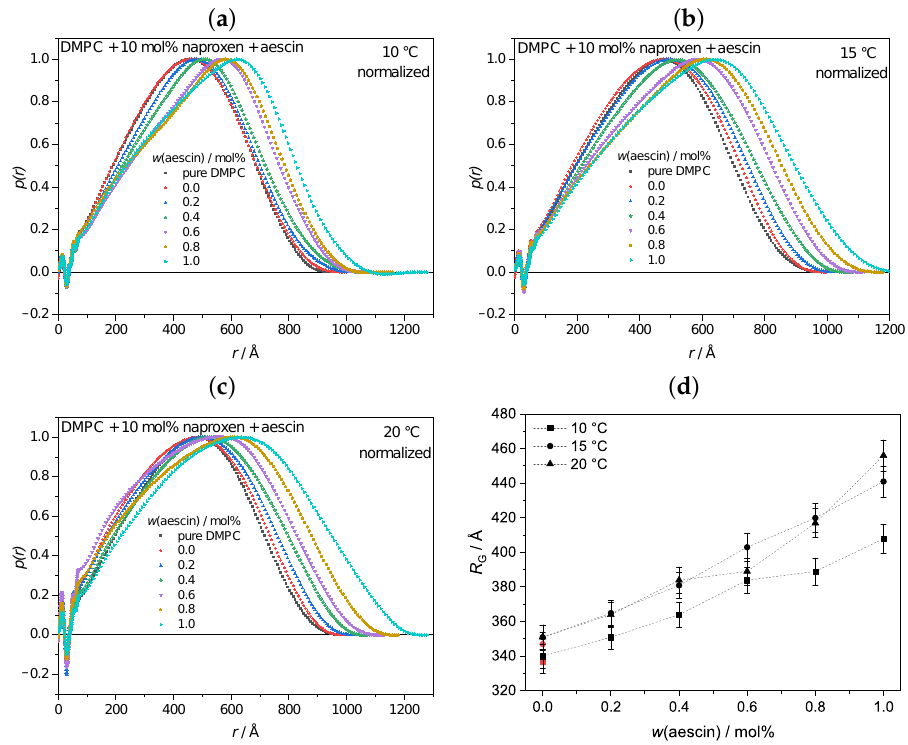
Figure 6. Pair distance distribution functions p ( r ) of pure DMPC vesicles and vesicles containing naproxen and aescin at ( a ) 10 °C, ( b ) 15 °C and ( c ) 20 °C. Functions were normalized to the maximum of p ( r ) for better comparability. ( d ) Radius of gyration R G of DMPC vesicles containing naproxen and different amounts of aescin against w (aescin) at T = 10 °C,15 °C and 20 °C. The dashed lines are only visual guides. The red symbols depict R G of pure DMPC